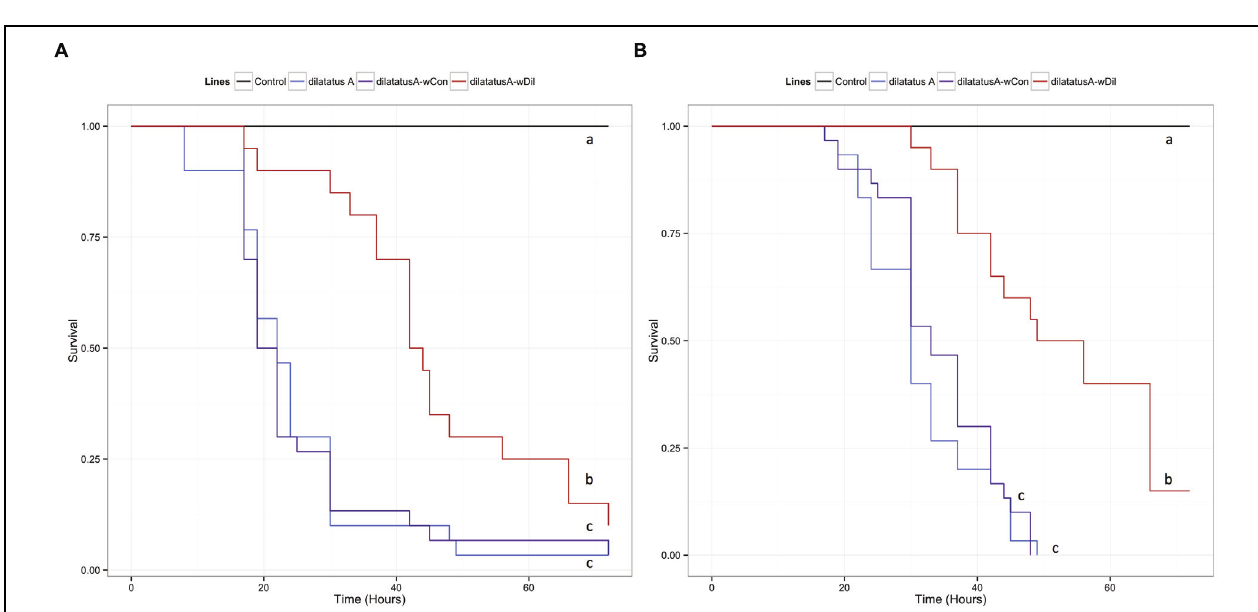
FIGURE 2 | Survival of the different A. vulgare lines when infected with S. typhimurium . A Cox proportional hazards model has been fitted using the survival data compared symbiotic and asymbiotic survival (A) BF w VulC and ZN/BF and (B) WX w /WXa A. vulgare lines after being injected with pathogenic bacteria S. typhimurium . Control groups were injected with liquid medium (LB). Different letters indicate significant differences between the survival curves of different lineages based on log-rank test p < 0.05.